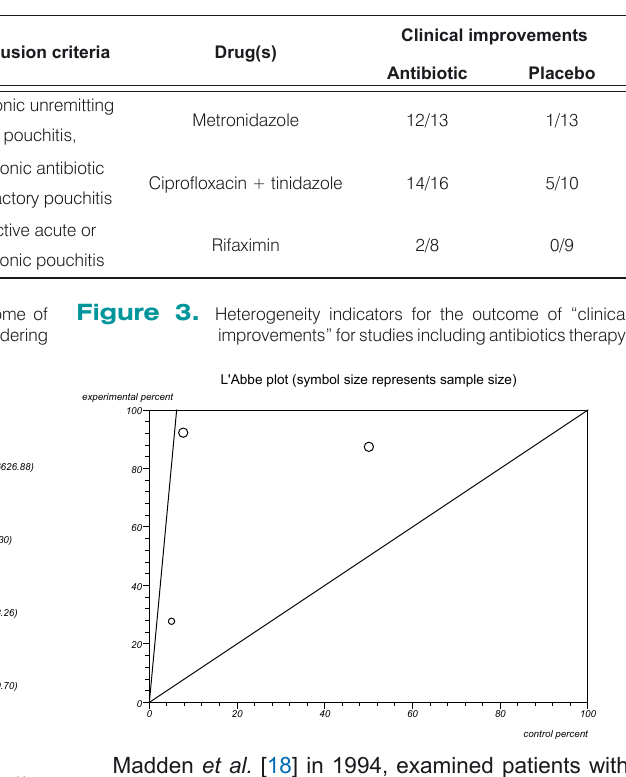
Table 2. Summary of controlled clinical trials included in the meta-analysis.